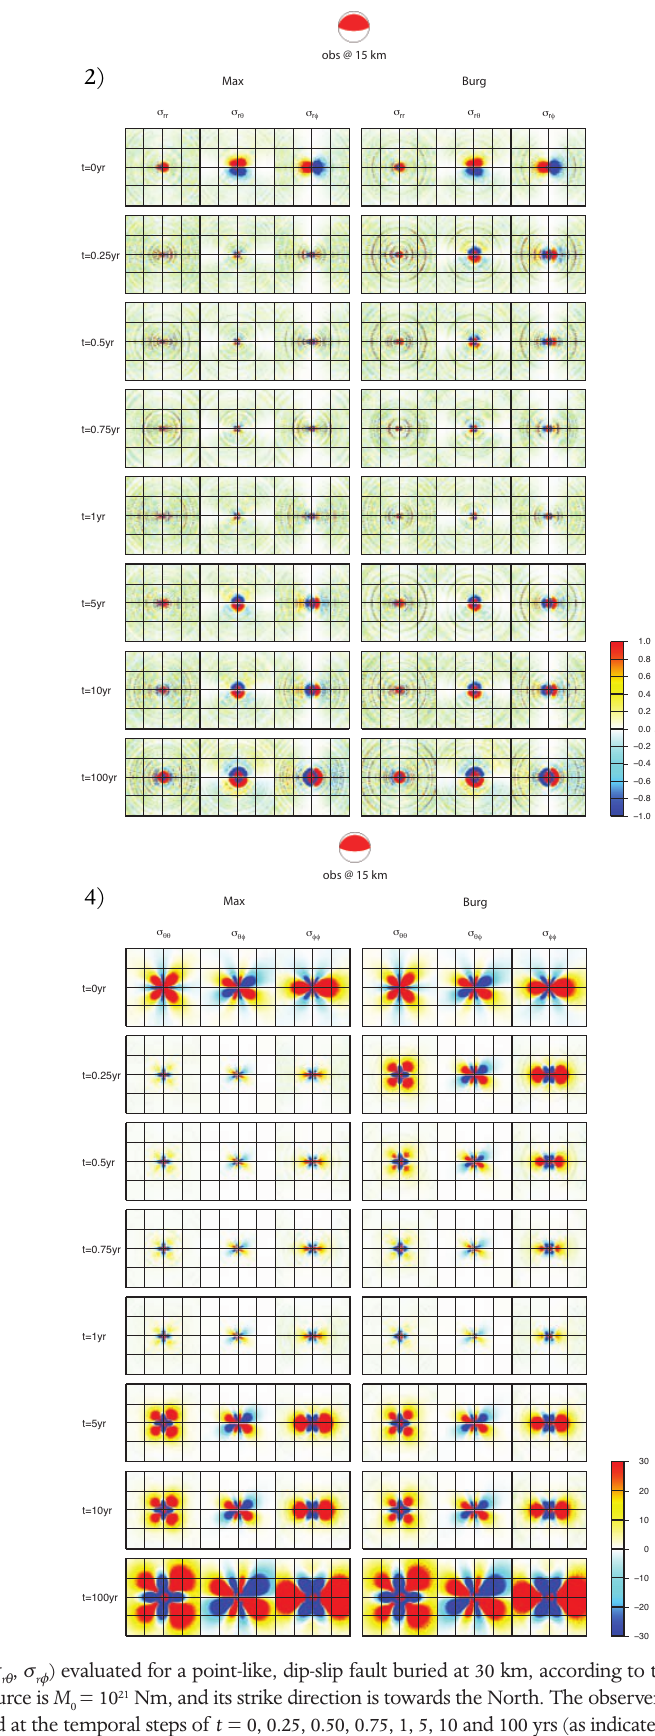
Figure 1. Temporal evolution of the radial stress tensor components ( v Maxwell (Max) and Burgers (Burg) rheologies. The scalar moment of the source is M located at 45 km in depth. The incremental stress perturbation was evaluated at the temporal steps of t = 0, 0.25, 0.50, 0.75, 1, 5, 10 and 100 yrs (as indicated), each with respect to the previous time step, except for t = 0, which represents the reference stress co-seismic field. The stress is expressed in Pascal (Pa). Figure 2. As for Figure 1, for an observer located at 15 km in depth. Figure 3. As for Figure 1, for the angular stress tensor components ( v observer located at 45 km in depth. Figure 4. As in Figure 1, for the angular stress tensor components ( v